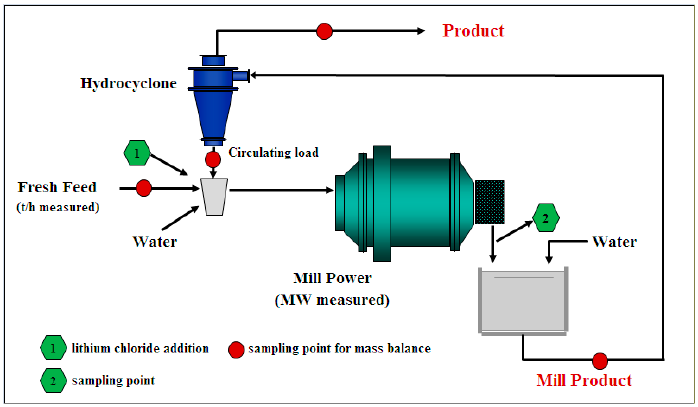
Figure 2. Sampling points in the industrial mill circuit.